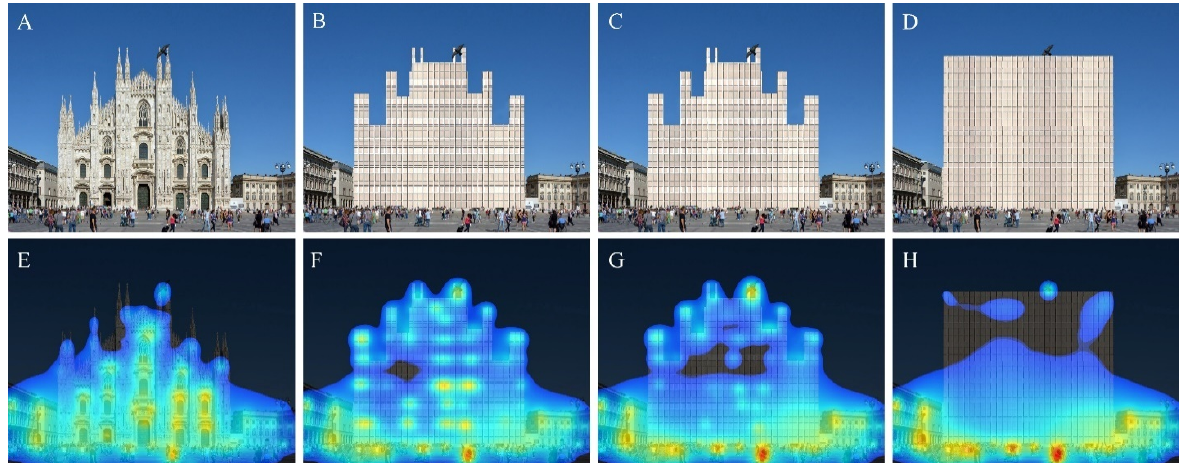
Figure 9. Piazza Duomo with the Duomo Cathedral in Milan, Italy ( A ) replaced by a curtain wall face of similar color ( B ) that gets progressively simpler by losing one set of horizontal lines per floor ( C ) and abandoning the detailed fractal outline of the building for a square profile ( D ). The sequence of corresponding eye-tracking simulation heatmaps ( E – H ) progressively focuses attention onto the ground plane, ignoring the building itself.